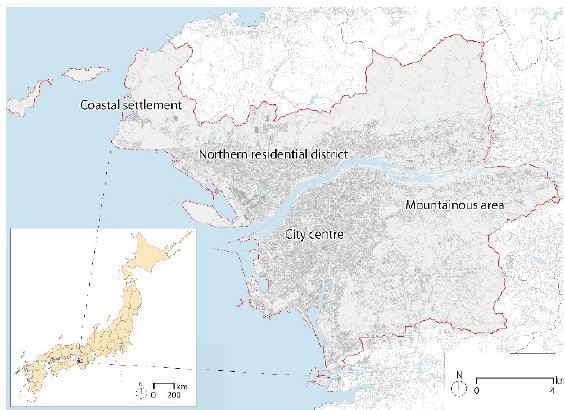
Figure 1. Geographic location of Wakayama